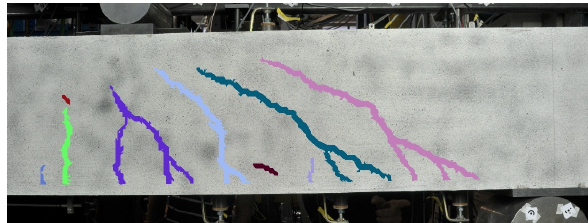
Figure 7. Reference and deformed triangle, vertex p 1 ref in reference and deformed state have the same